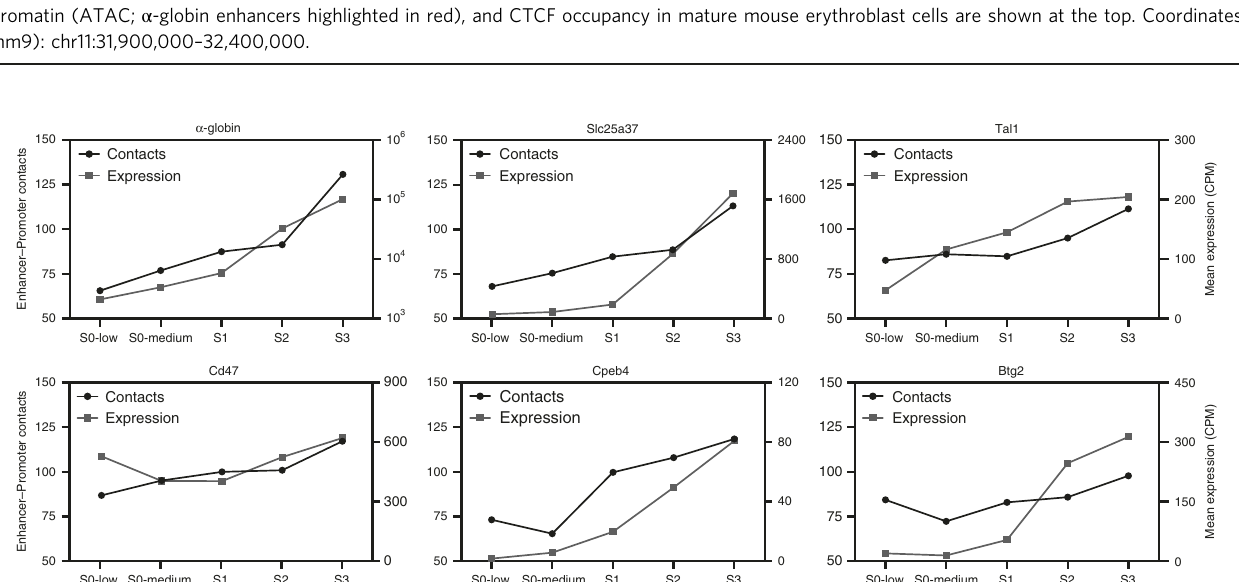
Fig. 5 Enhancer-promoter interactions are formed progressively during erythroid differentiation and correlate with upregulation of gene expression. Quanti fi cation of enhancer-promoter interactions and gene expression during in vivo erythroid differentiation at six erythroid gene loci. Contact frequencies (black circles; left Y -axis) represent unique interactions normalized for the total number of contacts in the matrix. Expression counts (gray squares; right Y - axis) represent mean expression in counts per million (CPM) for each population as determined by single-cell RNA-seq. Expression of α -globin, Slc25a37 and Tal1 , is upregulated early in differentiation, concomitant with increased enhancer-promoter interactions. Cd47 is expressed in hematopoietic stem cells and further upregulated later in erythroid differentiation when enhancer-promoter interactions are strengthened. Cpeb4 a nd Btg2 become robustly expressed in the S1 stage and are further upregulated as enhancer-promoter interactions increase later in